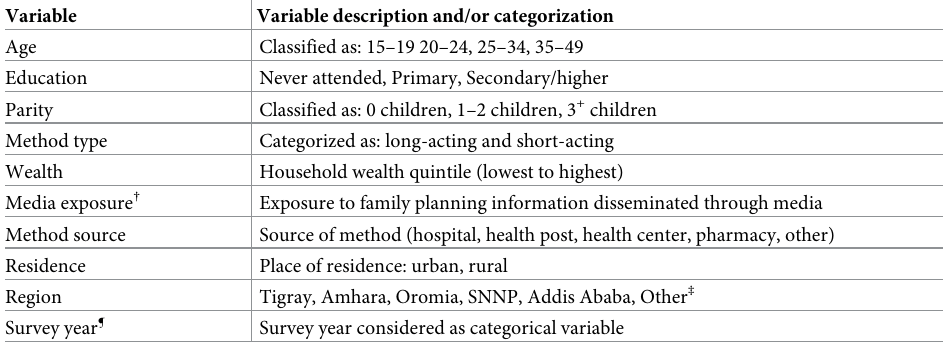
Table 1. Description of exploratory variables considered in the